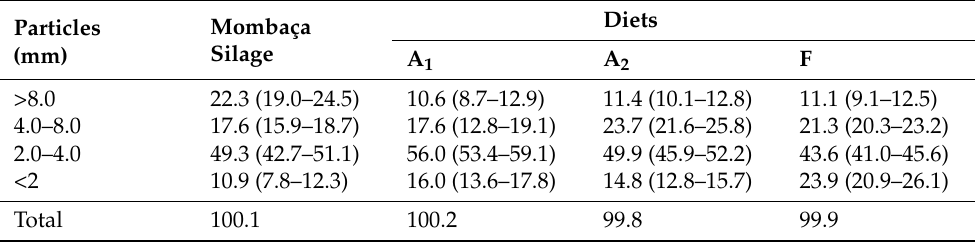
Table 6. Average of particle size distribution of the Mombaça silage and the diets of the traditional feedlot (May 2013). Values expressed in %.